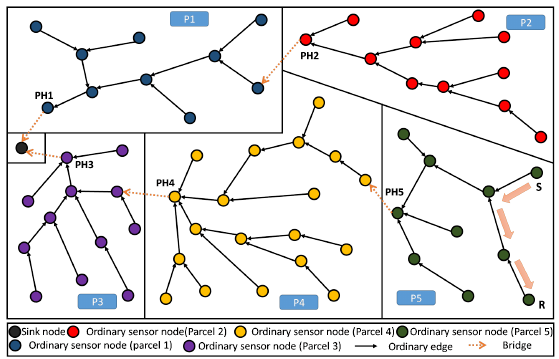
Figure 19. Intra-parcel message exchange with